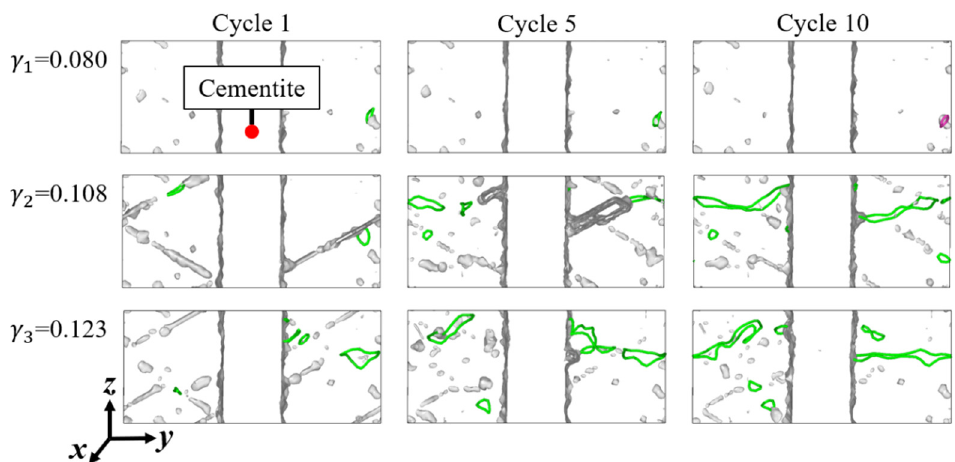
Figure 8. Dislocation distribution in the model under cyclic shear deformation along the x -axis. Ap- plied shear strain of 𝛾 (cid:2869) , 𝛾 (cid:2870) and 𝛾 (cid:2871) . Only dislocation distribution at the end of the cycle (1, 5, 10) is shown.